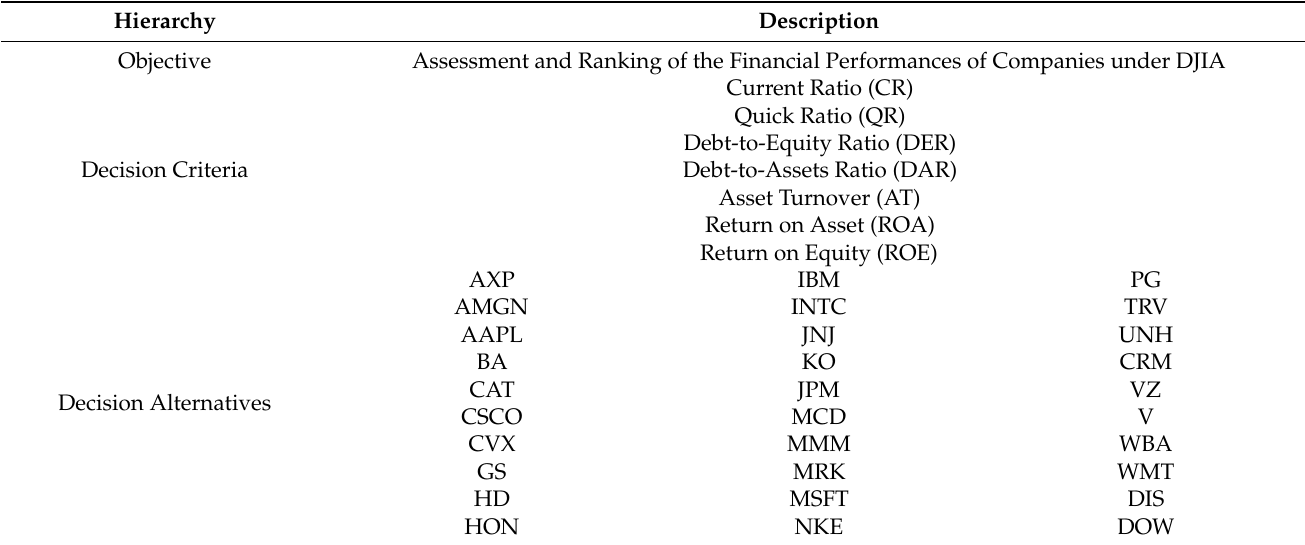
Table 1. Research framework